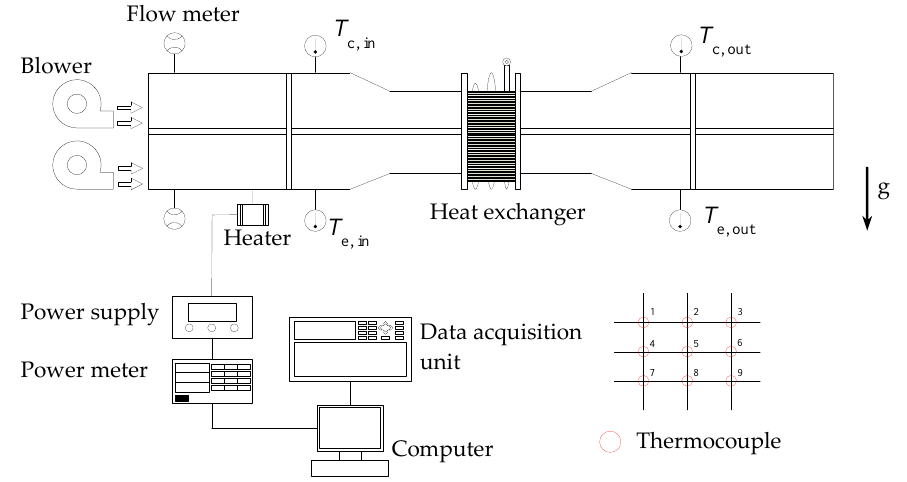
Figure 1. Schematic diagram of the present experimental setup.